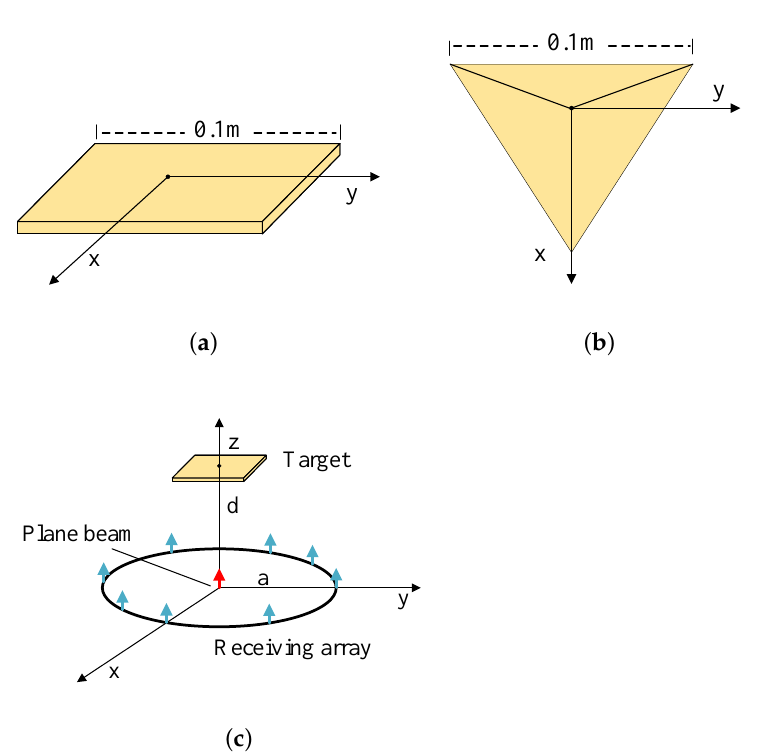
Figure 4. The simulation model. ( a ) The model of the plate. ( b ) The model of the trihedral corner reflector. ( c ) The overview of simulation.